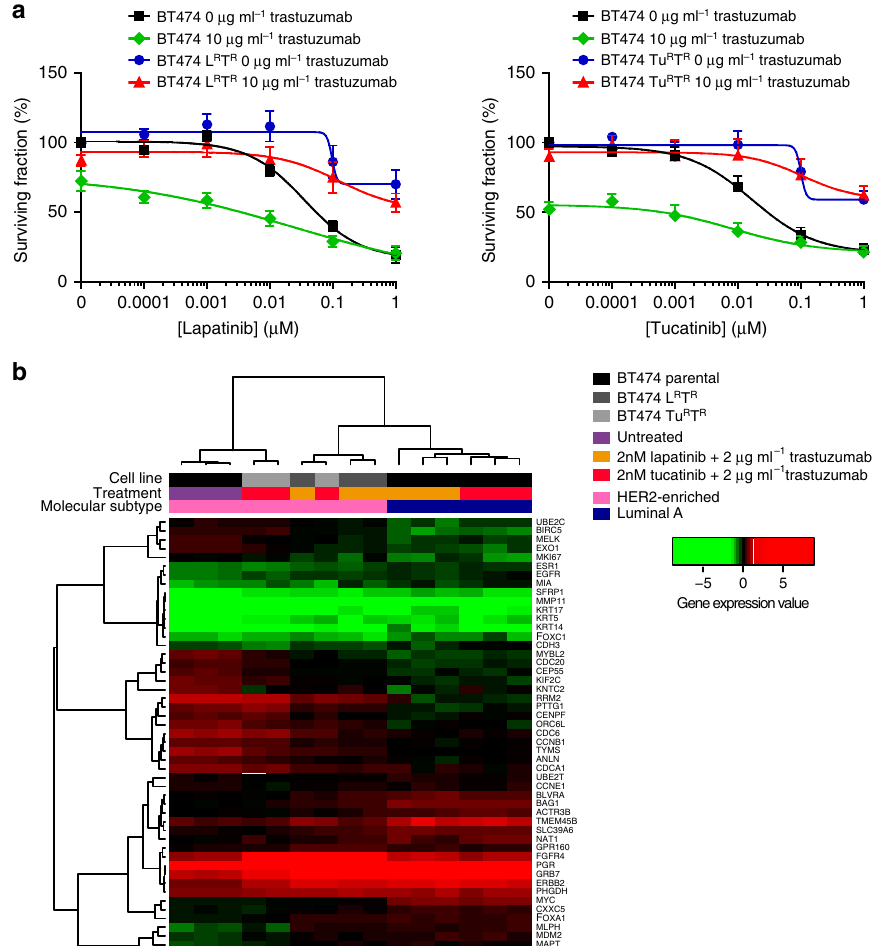
Fig. 4 Biological changes during anti-HER2 resistance. a Cell viability of BT474, BT474-derived lapatinib and trastuzumab resistant (BT474-L R T R ) and BT474-derived tucatinib and trastuzumab resistant (BT474-Tu R T R ) cells upon treatment with increasing doses of lapatinib + / − 10 μ g ml − 1 trastuzumab or increasing doses of tucatinib + / − 10 μ g ml − 1 trastuzumab, respectively. Data points represent the mean; error bars represent the standard error of the mean of 3 independent experiments. ( b ) Unsupervised hierarchical clustering in BT474, BT474-L R T R and BT474-Tu R T R treated with of 2 nM lapatinib plus 2 μ g ml − 1 trastuzumab or 2 nM tucatinib plus 2 μ g ml − 1 trastuzumab The heatmap shows high (red) to low (green) expression of mRNAs in each sample. The molecular subtype call and treatment of each sample is shown. Source data are provided as a Source Data fi